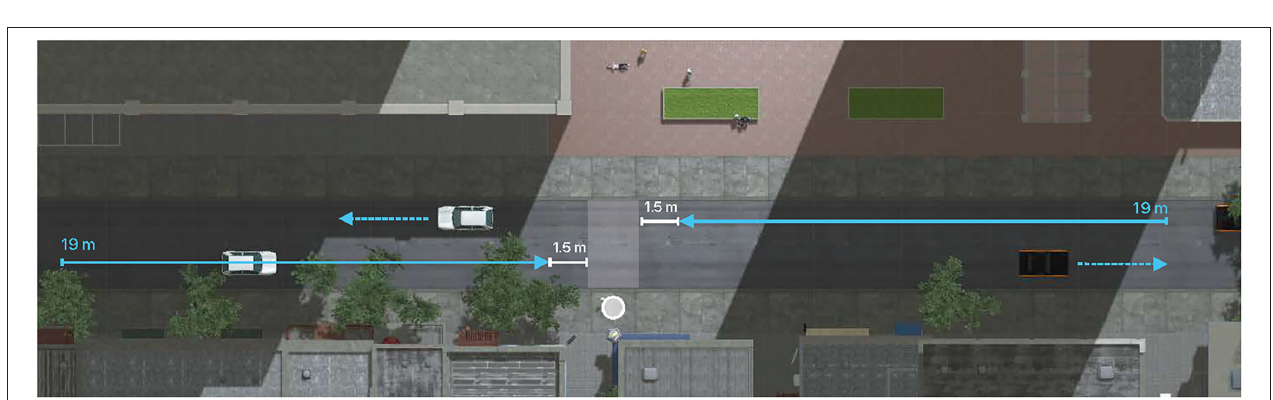
FIGURE 3 | Experimental setup: (A) the participant pressing the (virtual) pedestrian button; (B) the participant tapping the side of the HMD; (C) walking space and interview table; (D) virtual environment.